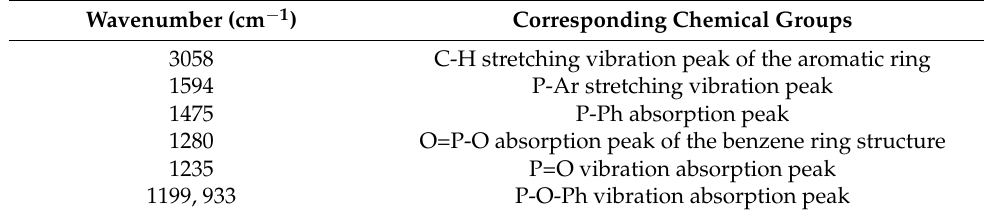
Figure 2. TGA and DTG curves of PBDOO in ( a ) Air and ( b ) N 2 . Table 2. TGA and DTG data of PBDOO and the VE composites. Sample